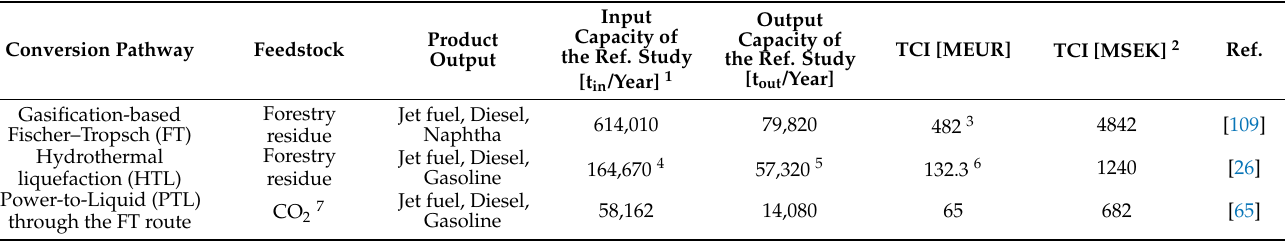
Table 3. Reference studies used to determine total capital investment (TCI) and the capacity for each conversion pathway in this study.